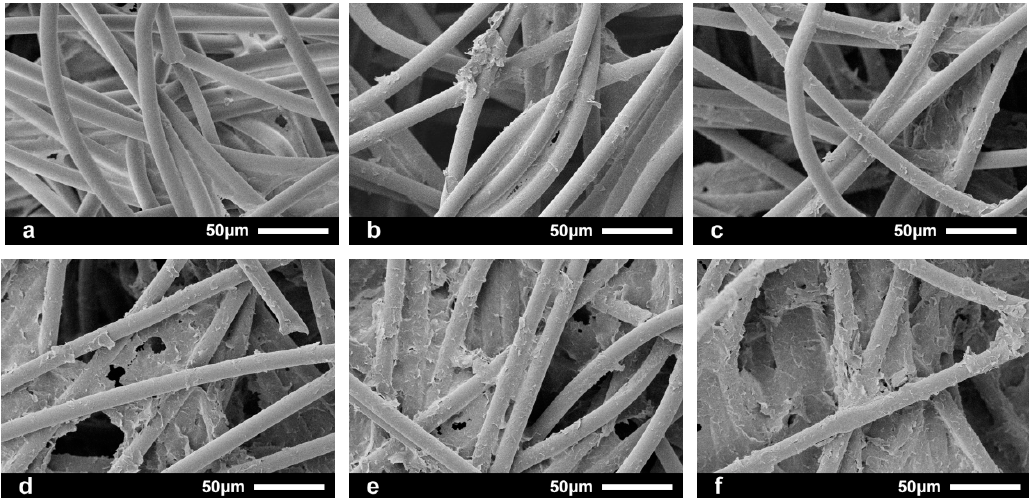
Figure 8. SEM images of composites with various GE content in coating agent, with ( a ) 0, ( b ) 5, ( c ) 10, ( d ) 15, ( e ) 20, and ( f ) 25 g/L.